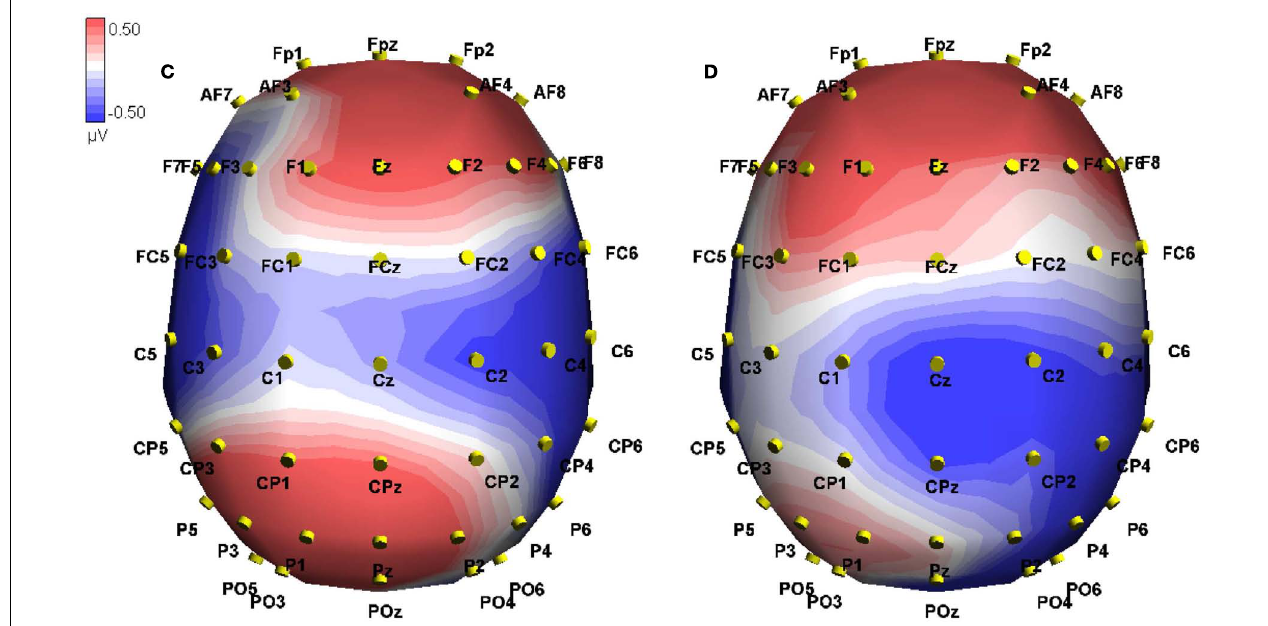
FIGURE 4 | Event-related potential in microvolts across the scalp at 377ms post onset of the critical word, approximately at the peak of the difference. Blue hues indicate negative potentials, red hues positive potentials.The two conditions shown are False-Mismatch (C) and False-Match (D) .